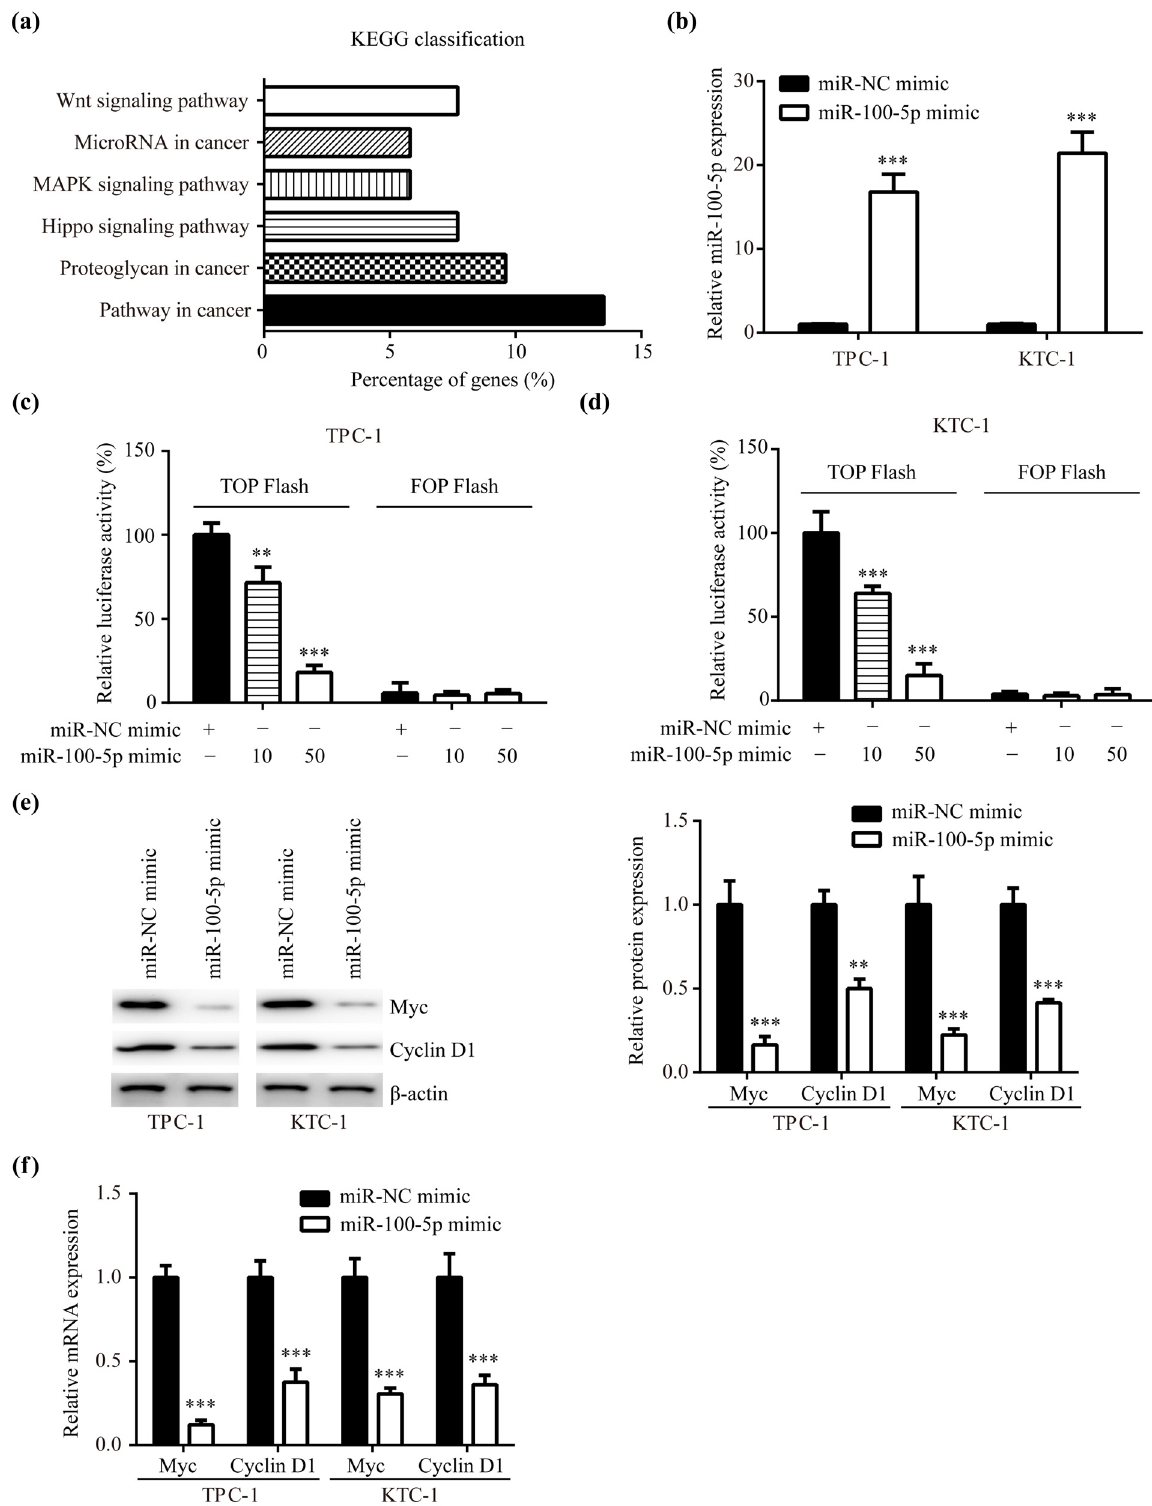
Figure 2: Wnt/ β - catenin signaling was repressed by miR - 100 - 5p in PTC: ( a ) KEGG pathway analysis was utilized for analyzing targets of miR - 100 - 5p predicted by TargetScan7.2, ( b ) RT - PCR presented that miR - 100 - 5p mimic elevated miR - 100 - 5p in TPC - 1 and KTC - 1, ( c and d ) the TOPFlash/FOPFlash assay presented that miR - 100 - 5p mimic reduced the activity of Wnt/ β - catenin pathway in TPC - 1 and KTC - 1 in a dose - dependent manner, ( e ) western blotting revealed that miR - 100 - 5p decreased Myc and Cyclin D1 protein levels in TPC - 1 and KTC - 1, and ( f ) RT - PCR revealed that miR - 100 - 5p decreased Myc and Cyclin D1 mRNA levels in TPC - 1 and KTC - 1. **, p < 0.01 and ***, p <